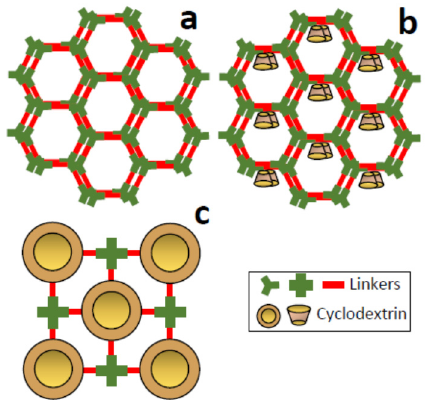
Figure 4. Schematic representation of the structures of ( a ) COF, ( b ) CD-functionalized COF, and ( c ) CD-containing COF.